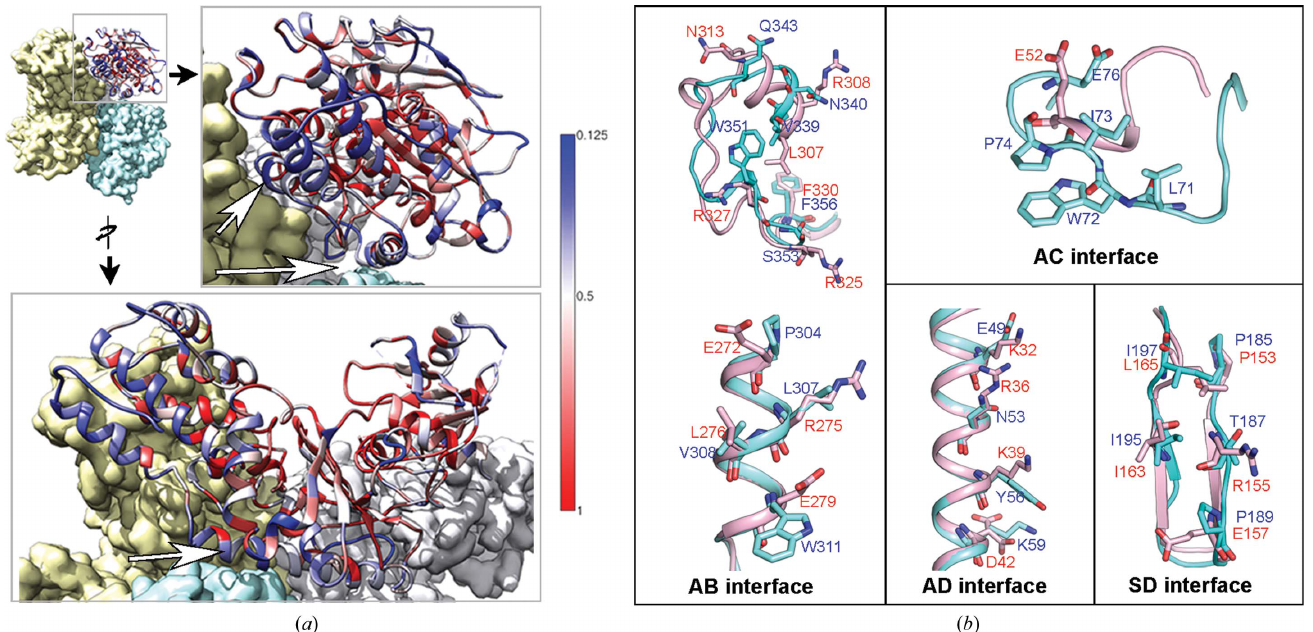
Figure 5 Comparison of PvHK with human hexokinase. ( a ) Sequence conservation of PvHK (compared with all human hexokinases). The residues facing the tetrameric interface are less conserved (blue). ( b ) Structural comparison between PvHK (cyan) and human hexokinase IV (pink) at each inter-protomer interface, highlighting distinct residues that mediate tetrameric contacts in